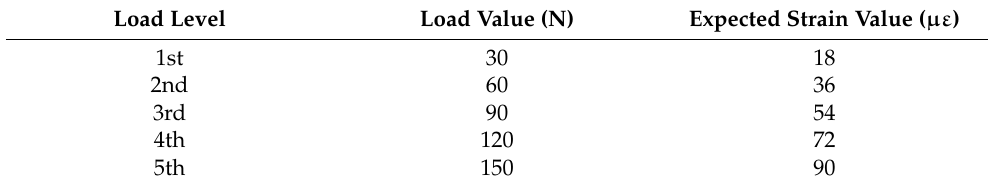
Table 2. Load values and corresponding expected strain levels of the five-level loading test.